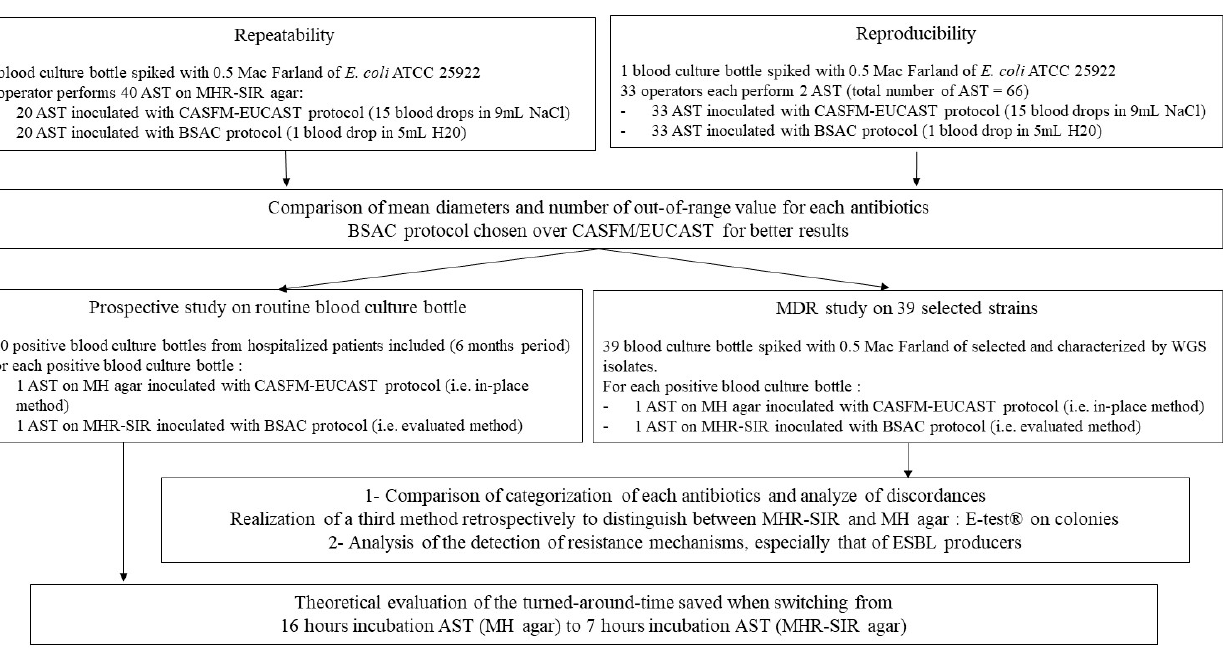
Figure 1. Description of study